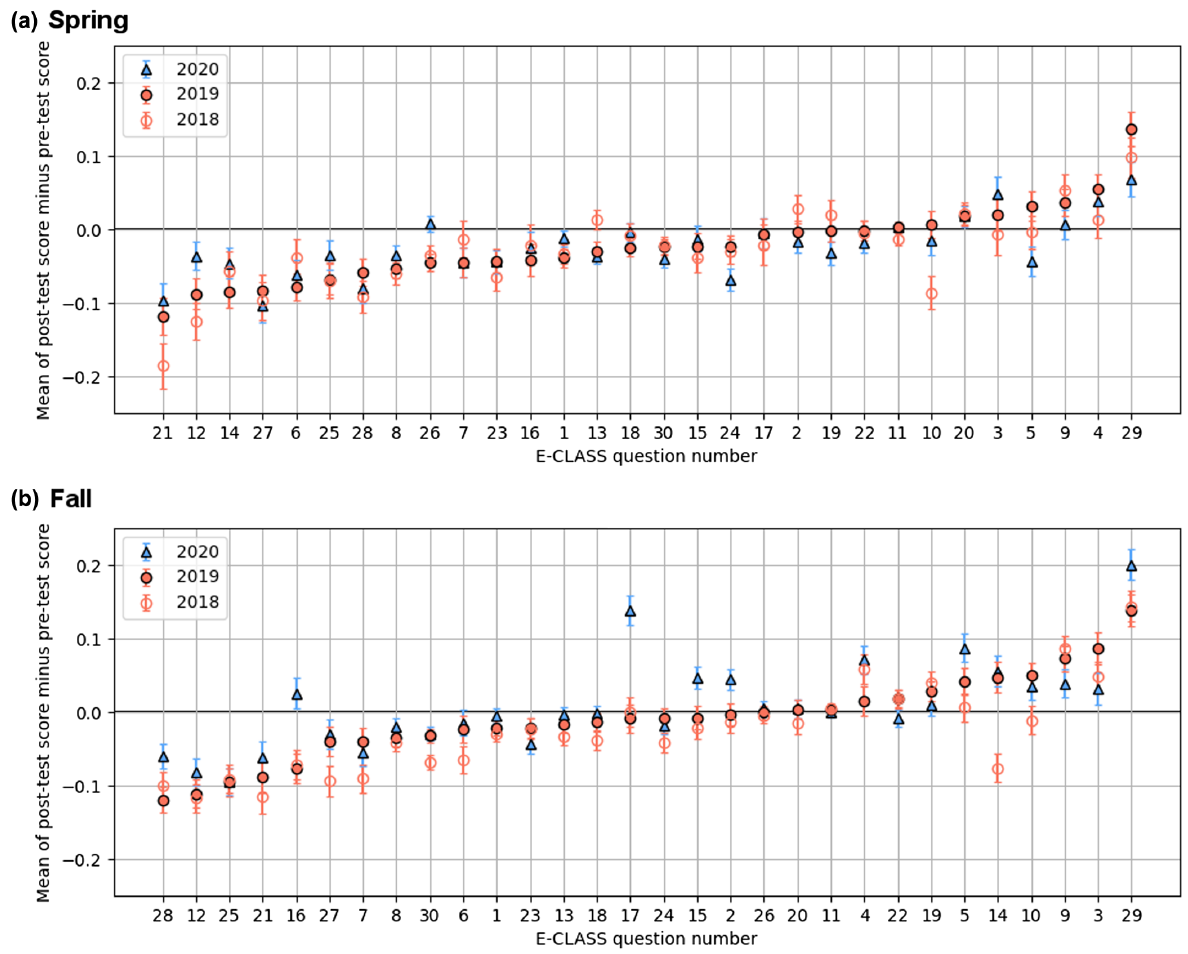
FIG. 2. Mean of the differences in student E-CLASS scores (post-test score minus pretest score) for individual questions for (a) spring and (b) fall semesters. In each panel blue triangles represent the 2020 data, solid red circles the 2019 data, and open red circles the 2018 data. Error bars indicate the standard error on the mean. A list of the E-CLASS questions can be found in Ref. [44]. Items are ordered based on increasing 2019 values. Apparent missing symbols for some questions indicate that the scores are the